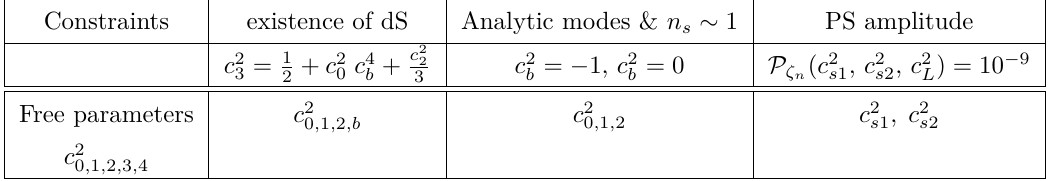
Figure 3. P R case.